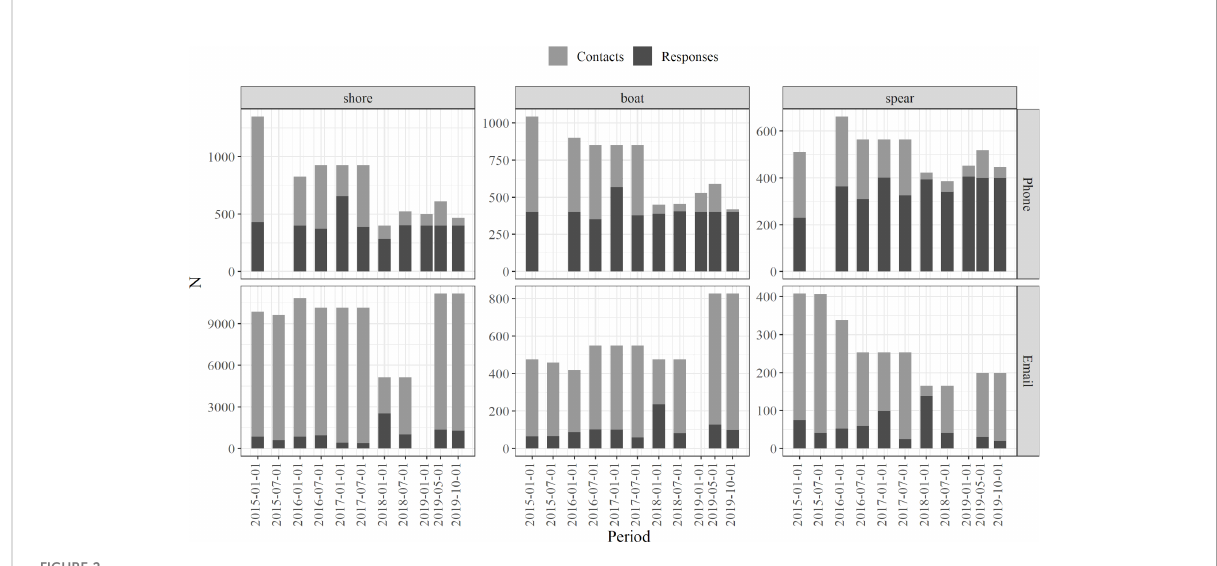
FIGURE 2 Number of contacted fi shers and obtained positive responses though different months of the sampling period (2015 – 2019), separated by survey type (i.e., phone calls and emails) and fi shing mode (i.e., shore fi shing, boat fi shing and spear fi shing). Note the different scales in Y